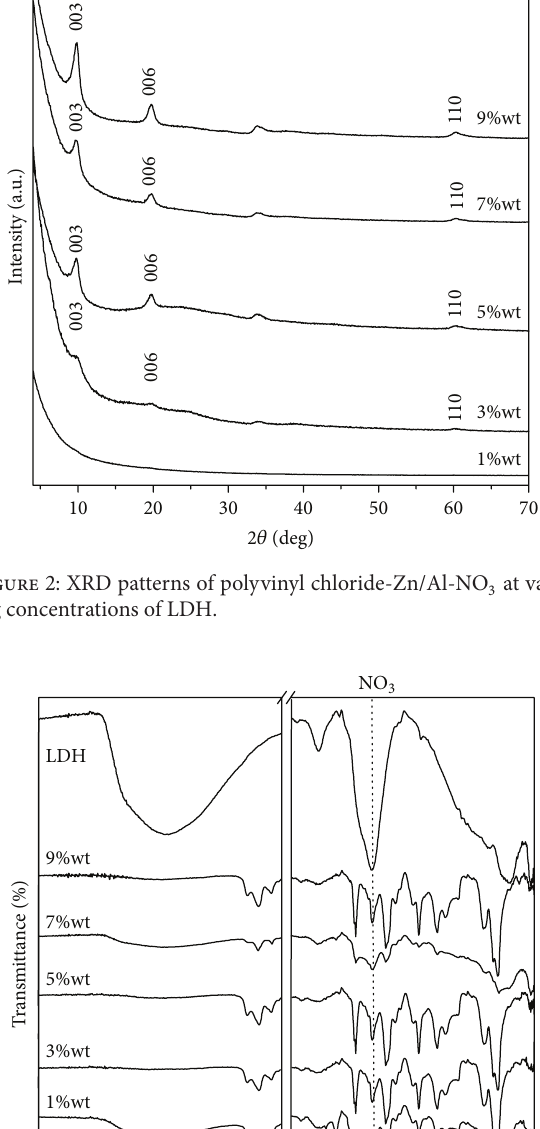
Table 1: XRD data of polyvinyl chloride-Zn/Al-NO